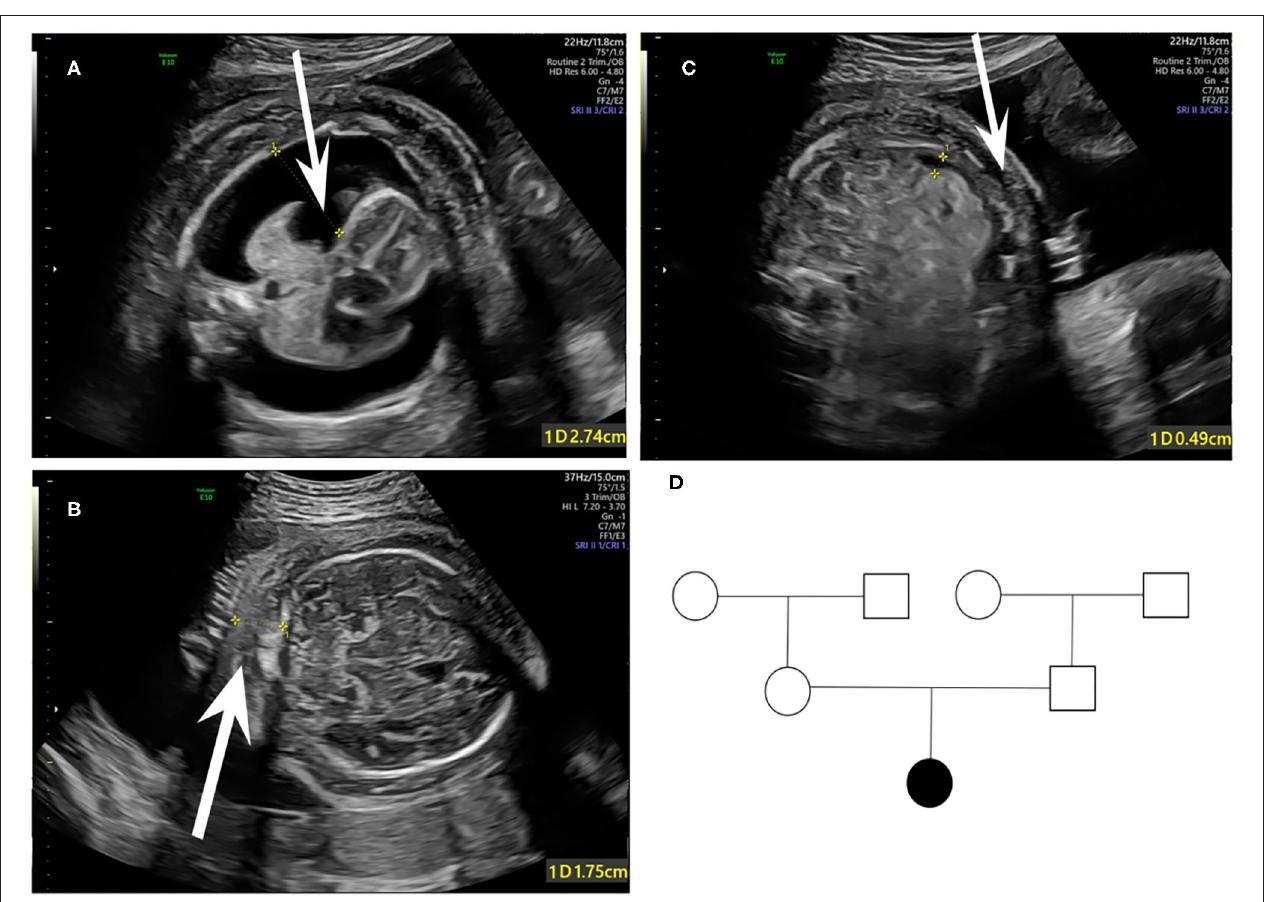
FIGURE 1 | Fetal sonographic findings at 31 gestation in the NIHF case with PIEZO1 mutations: (A) Bilateral pleural effusion on axial view. (B) Skin edema on axial view. (C) Peritoneal effusion on axial view. (D) Pedigree of the family. The affected fetus is marked in black.